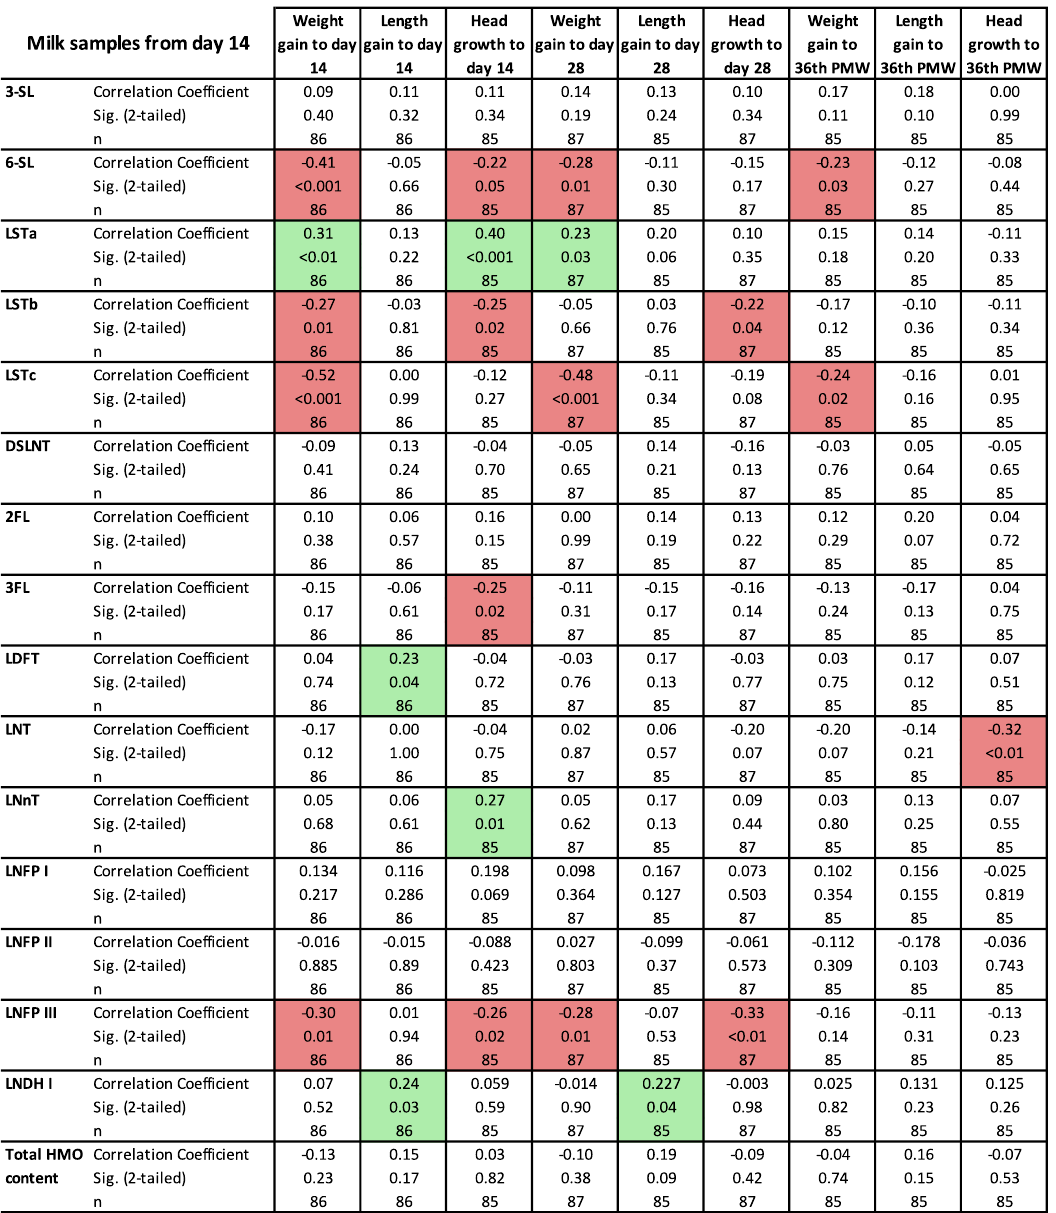
Figure 4. Correlations between concentrations of individual human milk oligosaccharide (HMO) (micromol/litre) in milk samples from day 14 and infant growth (change in z-score from birth to measurement on the 14 th or 28 th day of life or at 36 postmenstrual week (PMW), analysed using Spearman´s rho correlation coefficient. Significant correlations are highlighted with green for positive and red for negative correlations.